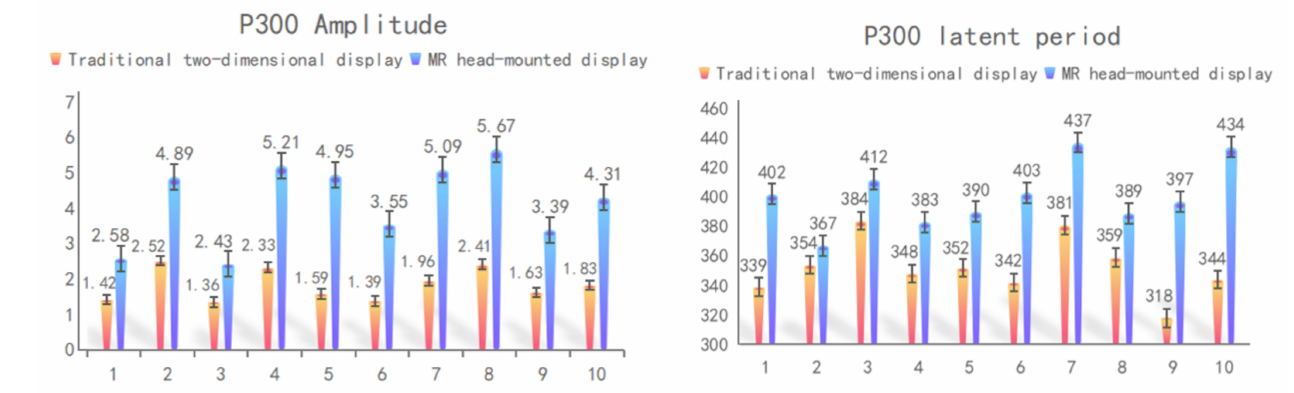
Figure 18. The experimenter’s P300 EEG data under the two display interaction systems.